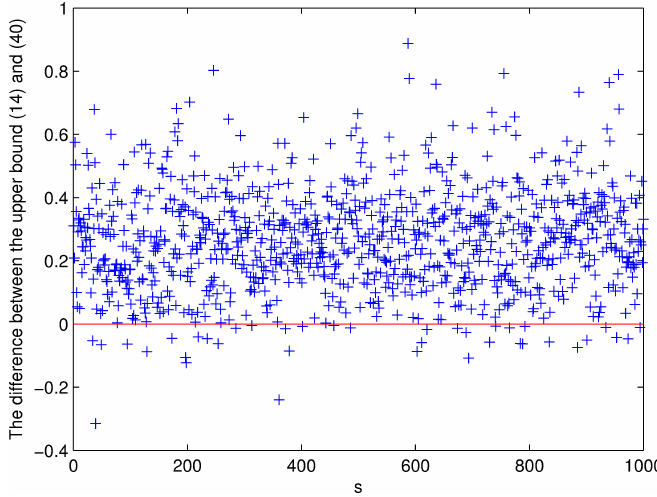
Fig. 1. The randomly generated results for Example